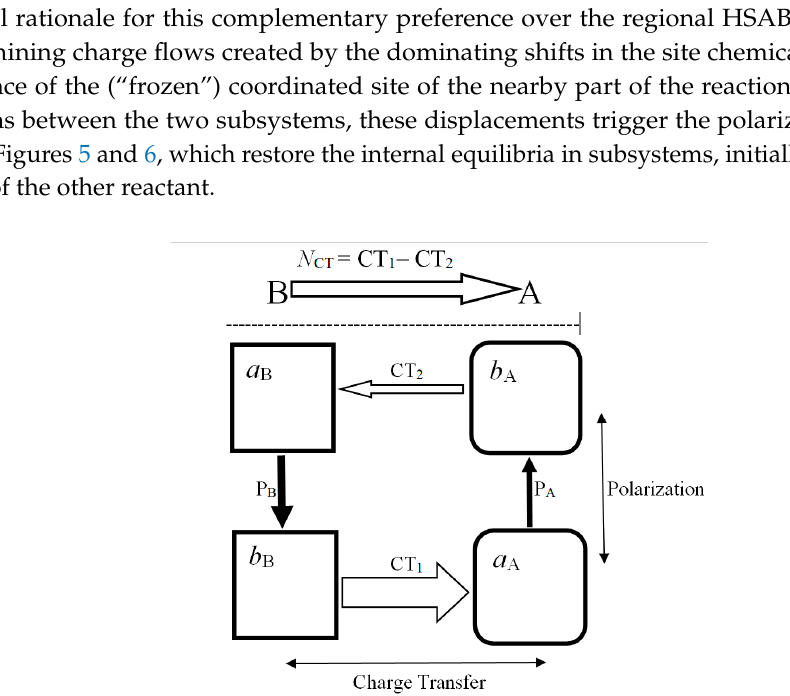
Figure 5. Polarizational {P α = ( a α → b α )} and charge-transfer {CT α = ( b α → a β )} electron flows, ( α , β≠α ) ∈ {A, B}, involving the acidic A = ( a A | b A ) and basic B = ( a B | b B ) reactants in the complementary arrangement R c of their acidic ( a ) and basic ( b ) fragments, with the chemically “hard” (acidic) fragment of one substrate facing the chemically “soft” (basic) part of its reaction partner. The polarizational flows {P α } (black arrows) in the mutually closed substrates, relative to the substrate “promolecular” references, preserve the overall numbers of electrons of isolated reactants { α 0 }, while the two partial {CT i } fluxes (white arrows), from the basic fragment of one reactant to the acidic part of the other reactant, generate a substantial resultant B → A transfer of N CT = CT 1 − CT 2 electrons between the mutually open reactants. These hypothetical electron flows in such a “complementary complex” are seen to produce an effective concerted (“circular”) flux of electrons between the four fragments invoked in this regional “functional” partition, which precludes an exaggerated depletion or concentration of electrons on any fragment of reactive